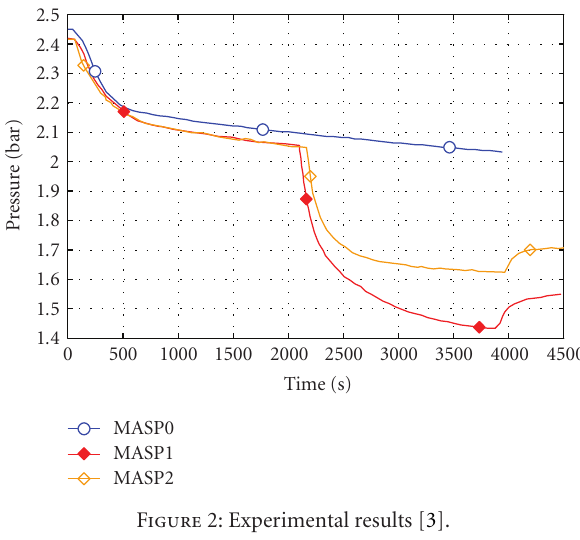
Figure 2: Experimental results [3].